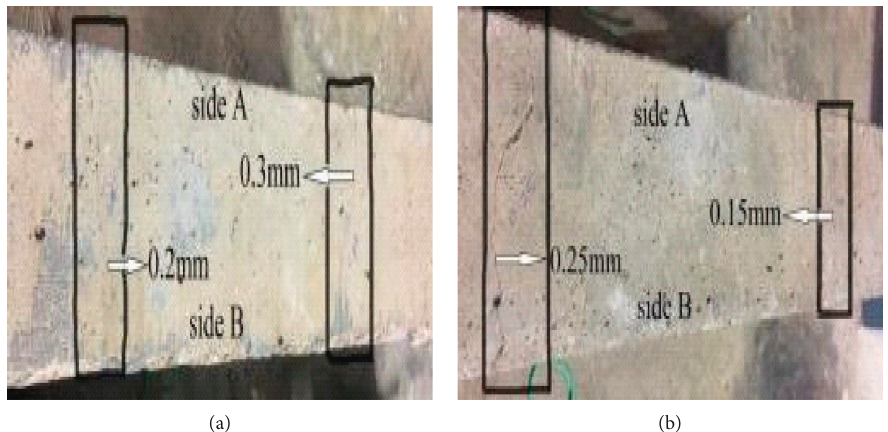
Figure 2: Details of cracks for conventional specimens. (a) OPC concrete mix. (b) PPC concrete